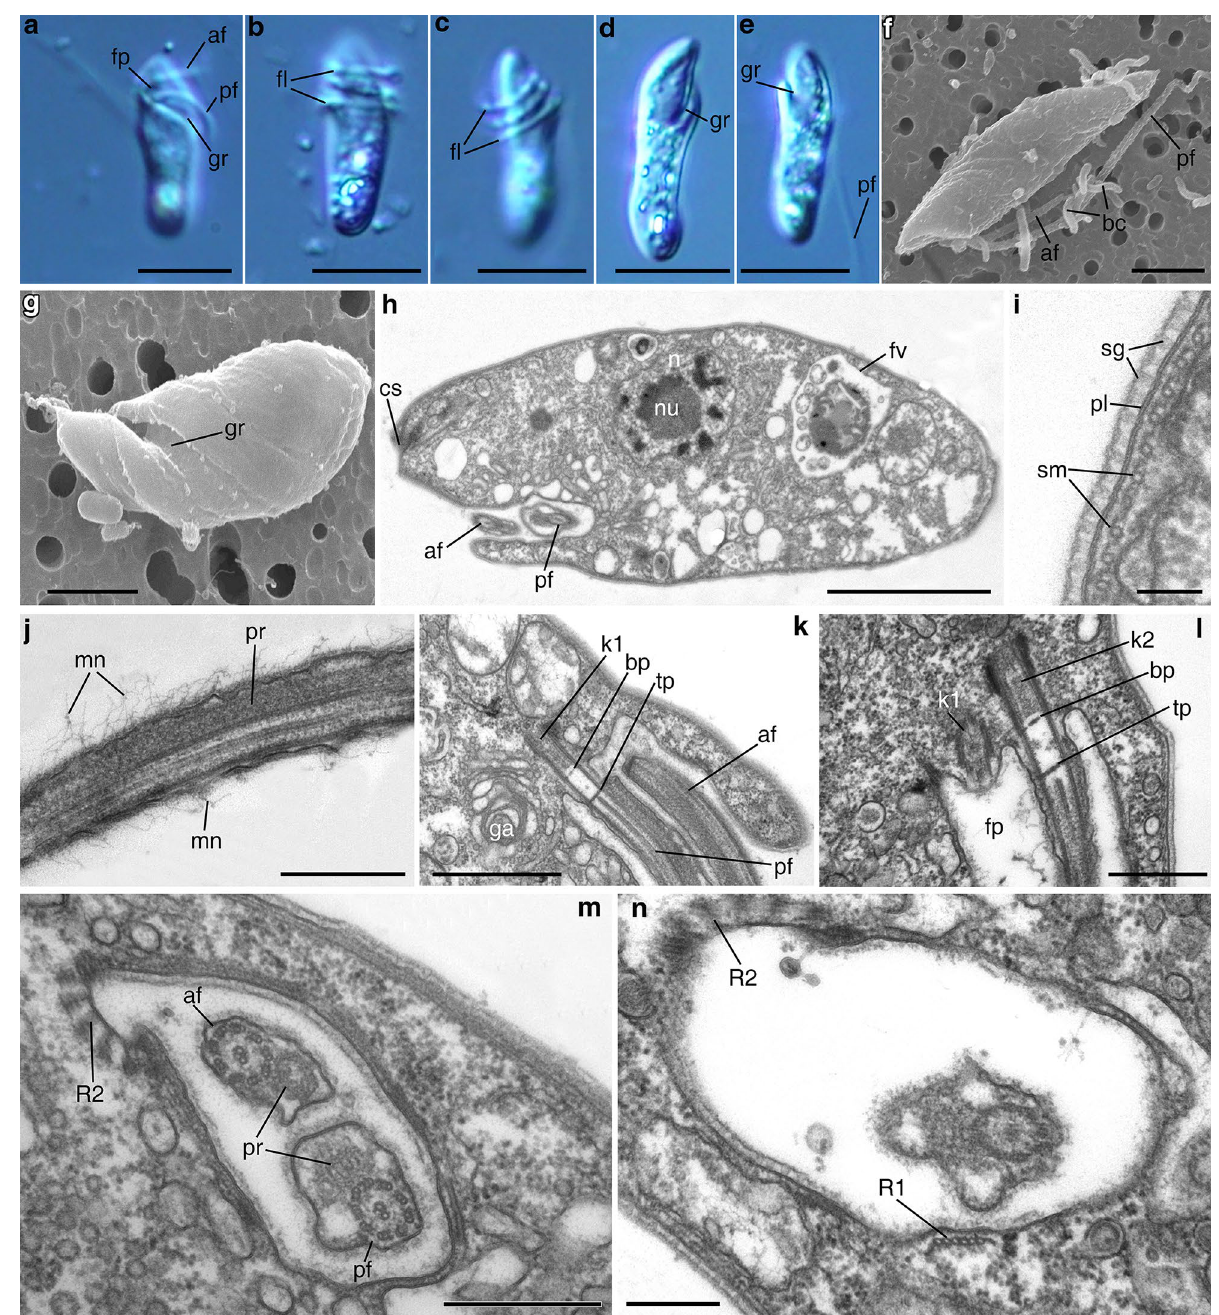
Figure 2. General view, cell coverings, and flagellar pocket of Papus ankaliazontas , clone PhM-4. (a–e) living cells, LM, DIC; (f, g) general cell view, SEM ( g flagella are not visible); (h) longitudinal cell section; (i) coverings structure; (j) anterior flagellum; (k, l) arising of the flagella from flagellar pocket; (m, n) cross sections of the flagellar pocket. af anterior flagellum, bc bacterium, bp basal plate, cs cytostome, fl flagella, fp flagellar pocket, fv food vacuole, ga Golgi apparatus, gr groove, k1 kinetosome (basal body) of the posterior flagellum; k2 kinetosome (basal body) of the anterior flagellum, mn mastigonemes, n nucleus, nu nucleolus, pf posterior flagellum, pl plasmalemma, pr paraflagellar rod, R1 mucrotubular root R1, R2 mucrotubular root R2, sg structured glycocalyx, sm subpellicular microtubules, tp transversal plate. Scales: ( a – e ) 10, ( f ) 3, ( g ) 2, ( h ) 3, ( i ) 0.1, ( j ) 0.5, ( k ) 1, ( l – m ) 0.5, ( n ) 2.5